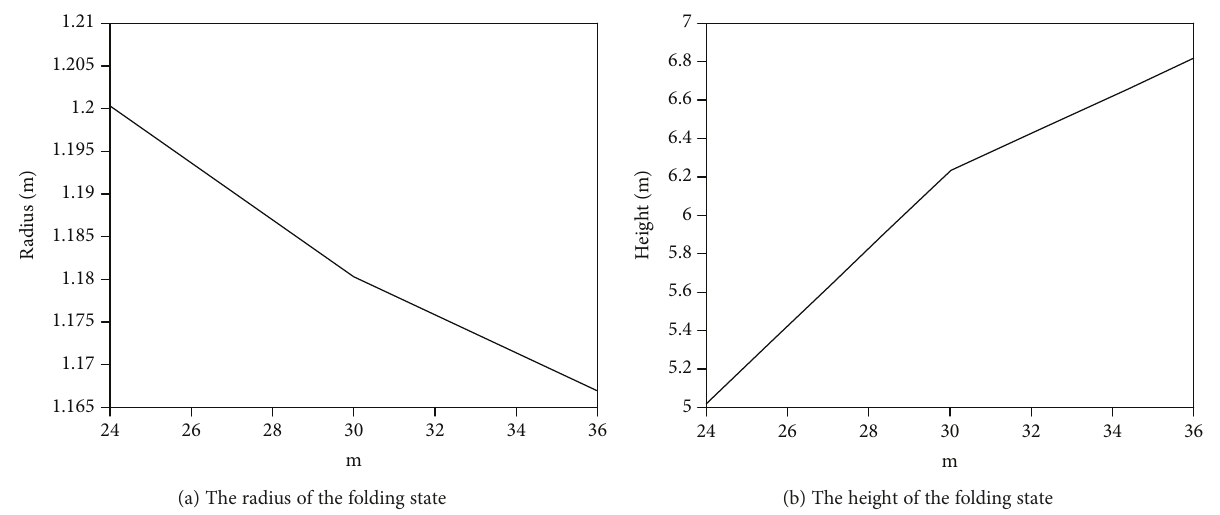
Figure 11: Change of the radius and the height of folding state with m .